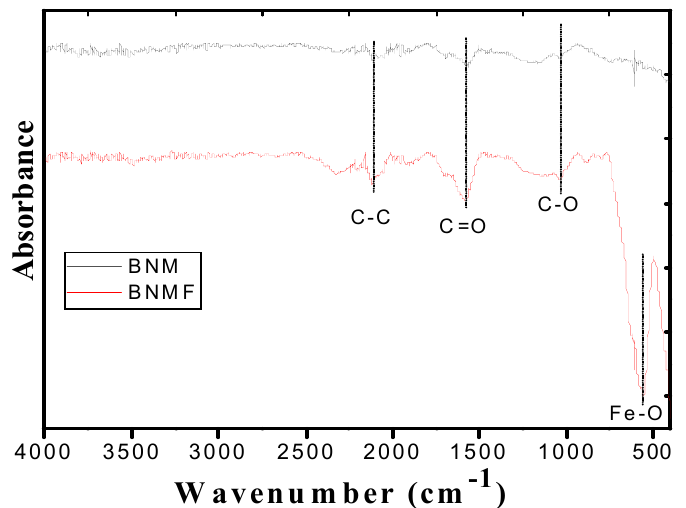
Figure 2. FTIR spectra of biochar (BNM) and ferromagnetic biochar (BNMF).